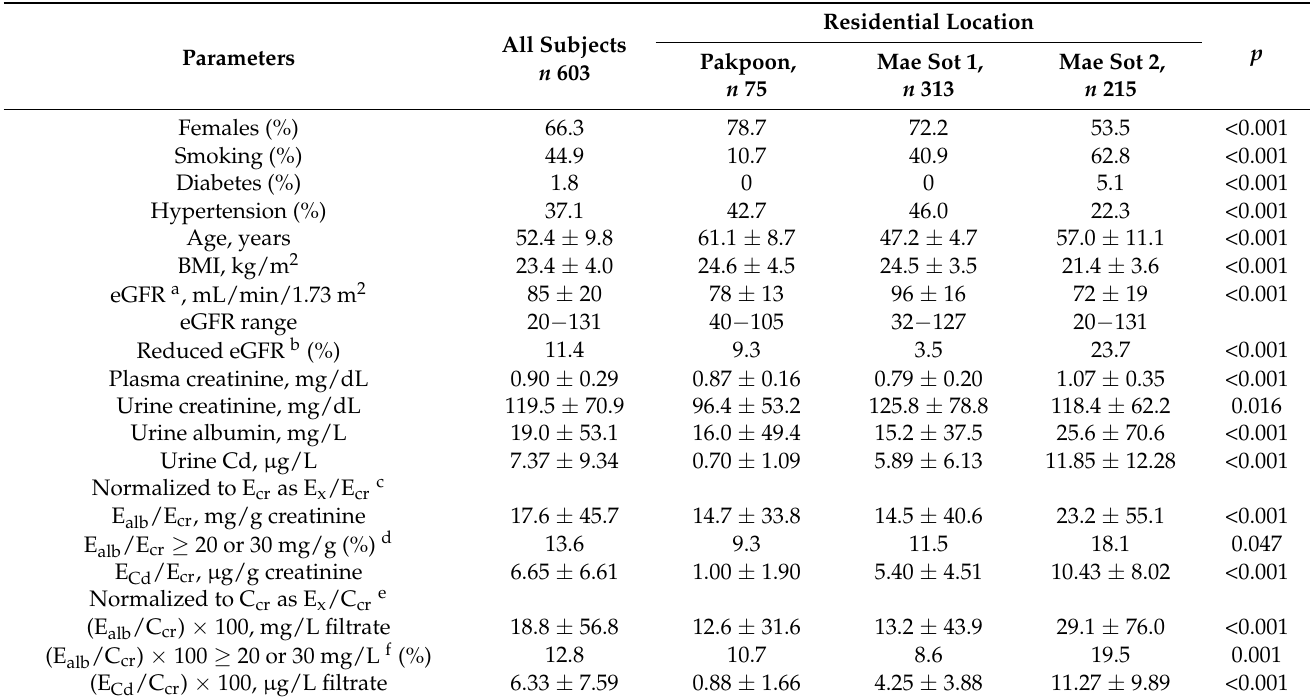
Table 1. Study subjects according to residential